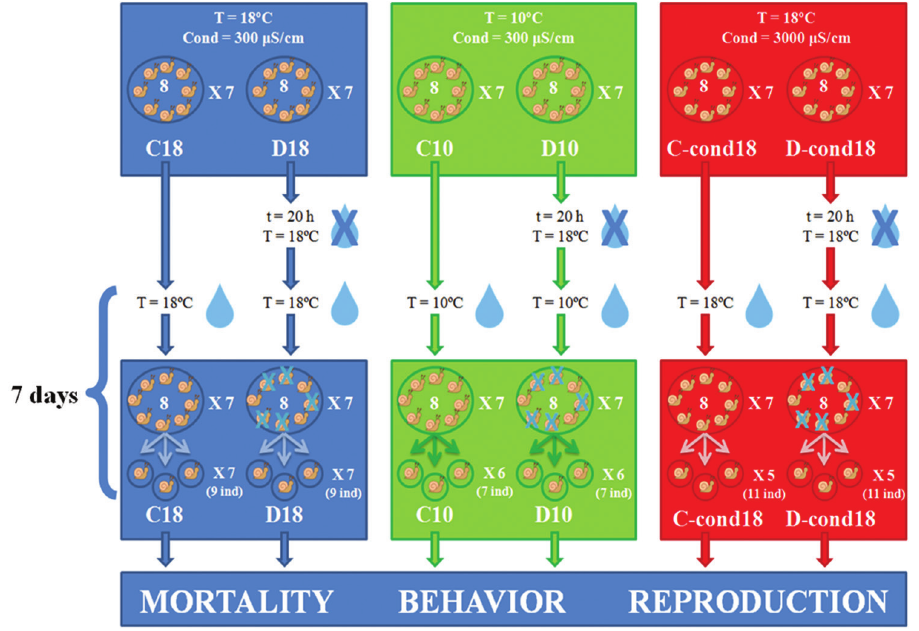
Figure 1. Diagram of the experimental Table 1. Physical and chemical properties of desiccation treatments and their respective controls. In the treatment code “D” means “desiccation” and “C” means “control” (not subjected to desiccation); the number indicates target water temperature and “cond” indicates high conductivity. C18: normal tempera- ture and normal conductivity control; D18: desiccation treatment with normal temperature and normal conductivity; C10: low temperature and normal conductivity control; D10: desiccation treatment with low temperature and normal conductivity; C-cond18: high conductivity and normal temperature control; D-cond18: desiccation treatment with high conductivity and normal temperature.